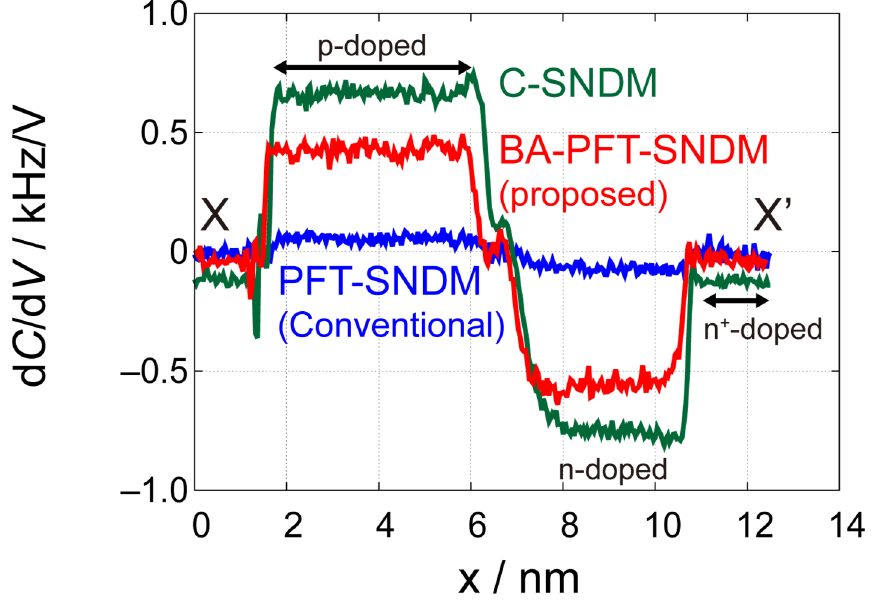
Figure 9. Comparison of the line profiles extracted from the C-SNDM [Figure 8b], PFT-SNDM [Figure 8c], and BA-PFT-SNDM (Figure 8e) images. The profiles are taken along the line from X to X’ in Figure 8.